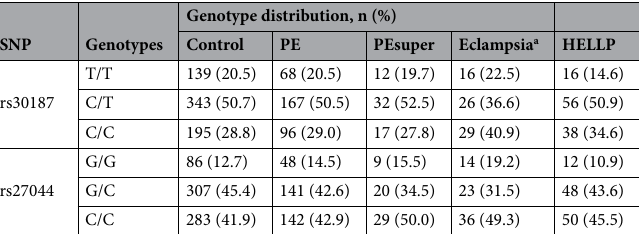
Table 3 . Genotype distribution for ERAP1 variants across phenotypic groups. a Chi-squared test of genotypic association for Control vs Eclampsia: p = 0.055 for rs30187 and p = 0.079 for rs27044.